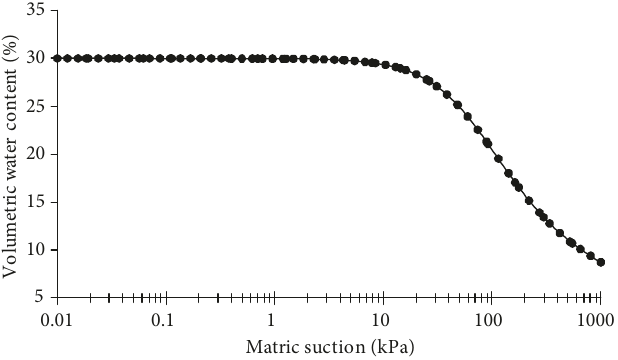
Figure 6: Soil and water characteristic curve.